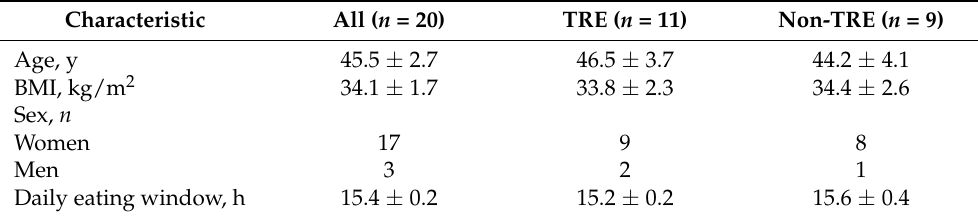
Table 2. Baseline characteristics.